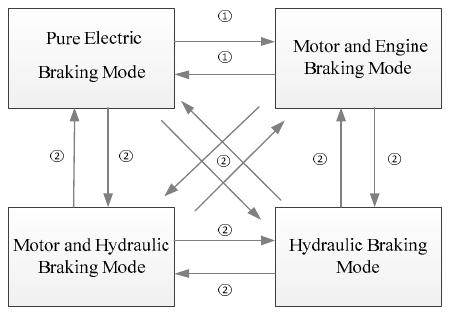
Figure 6. Braking mode switch classification.